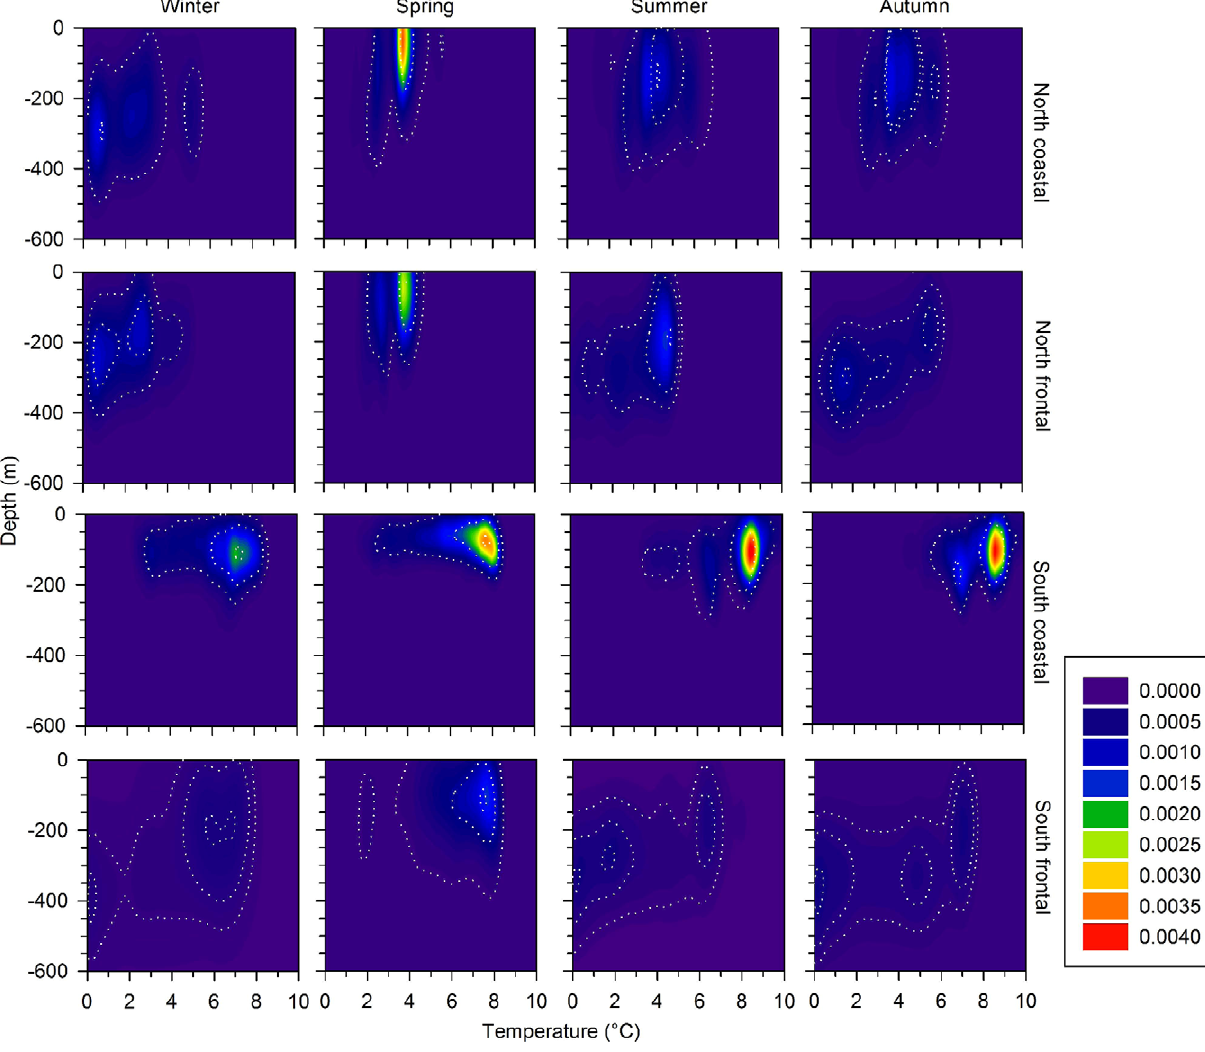
Figure 5. Bivariate kernel density estimates of seasonal thermal-bathymetric niches occupied by Atlantic cod ecotypes around Iceland. Dotted lines enclose the 95 th , 50 th , and 10 th percentiles of the distributions.